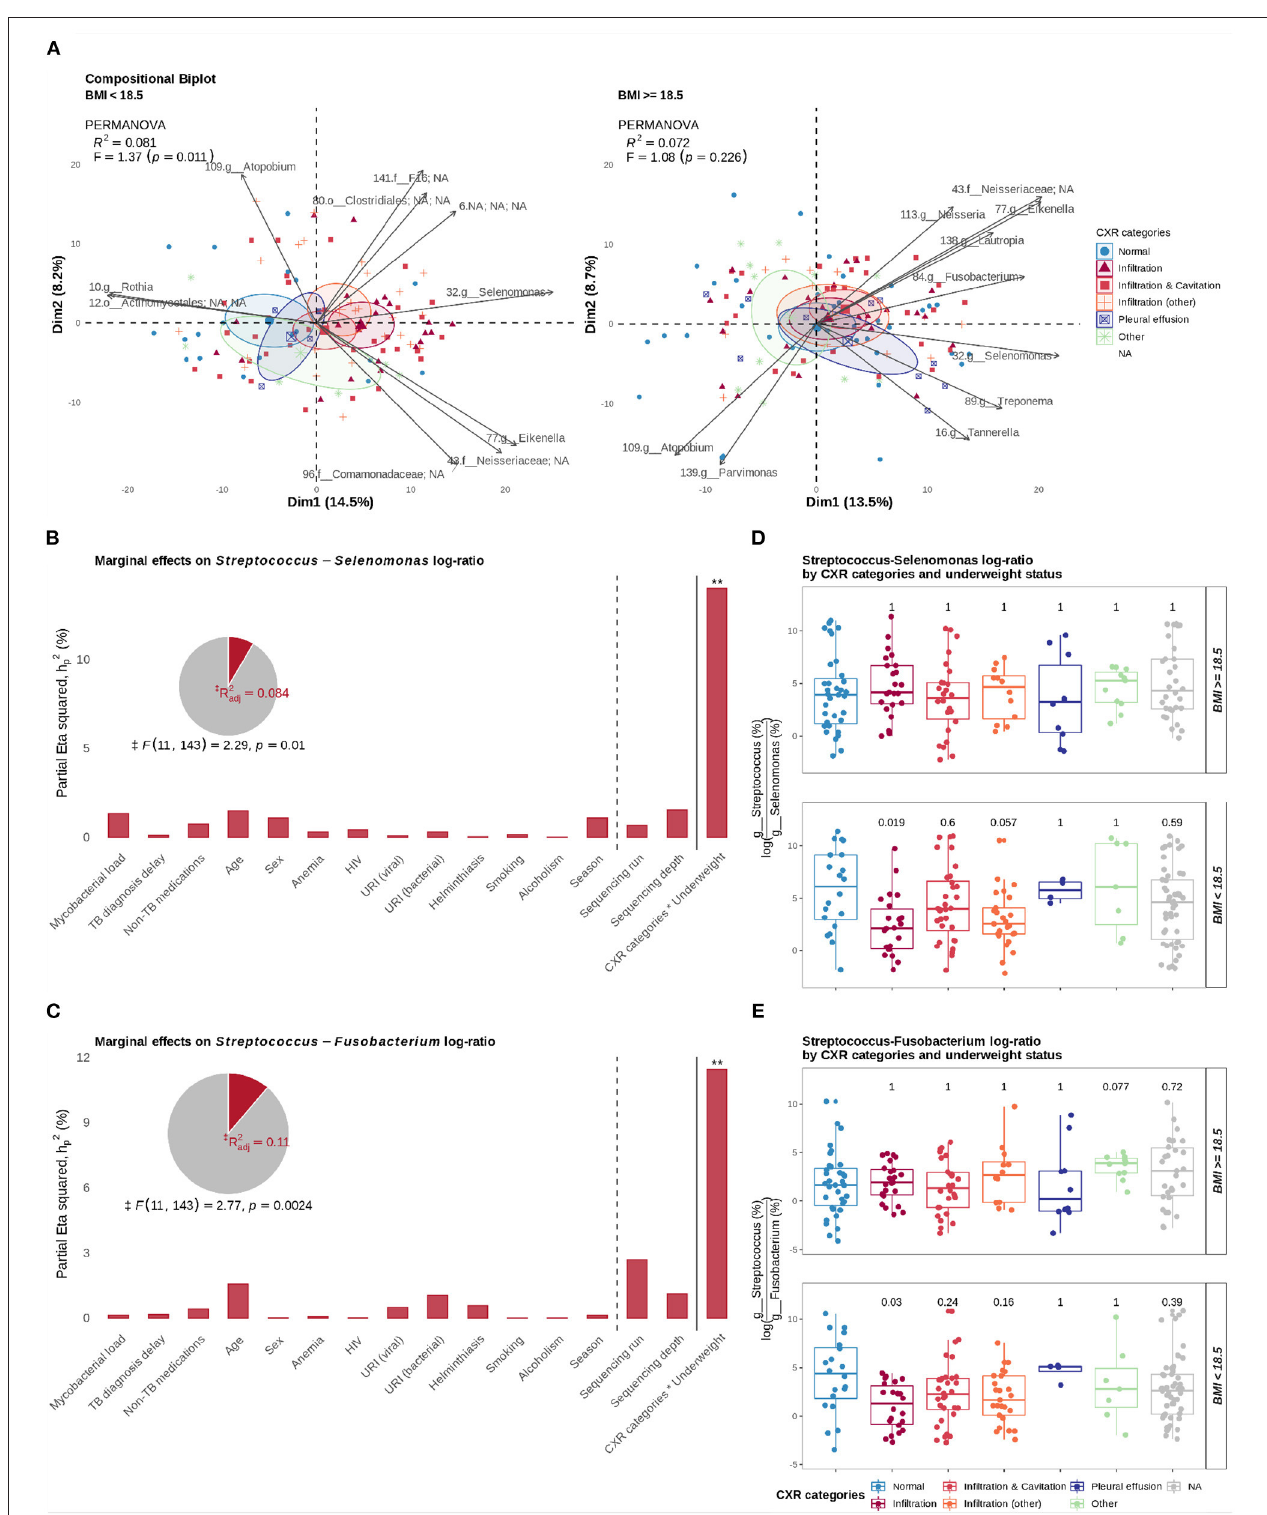
FIGURE 5 | Associations with compositional variation and log-ratios of interacting taxa. (A) Relative variation biplots, stratified by underweight status (BMI < 18.5 and BMI ≥ 18.5), show the effect of underweight status on the association between differences in genus-level log-ratio abundances and CXRs categories. (B)